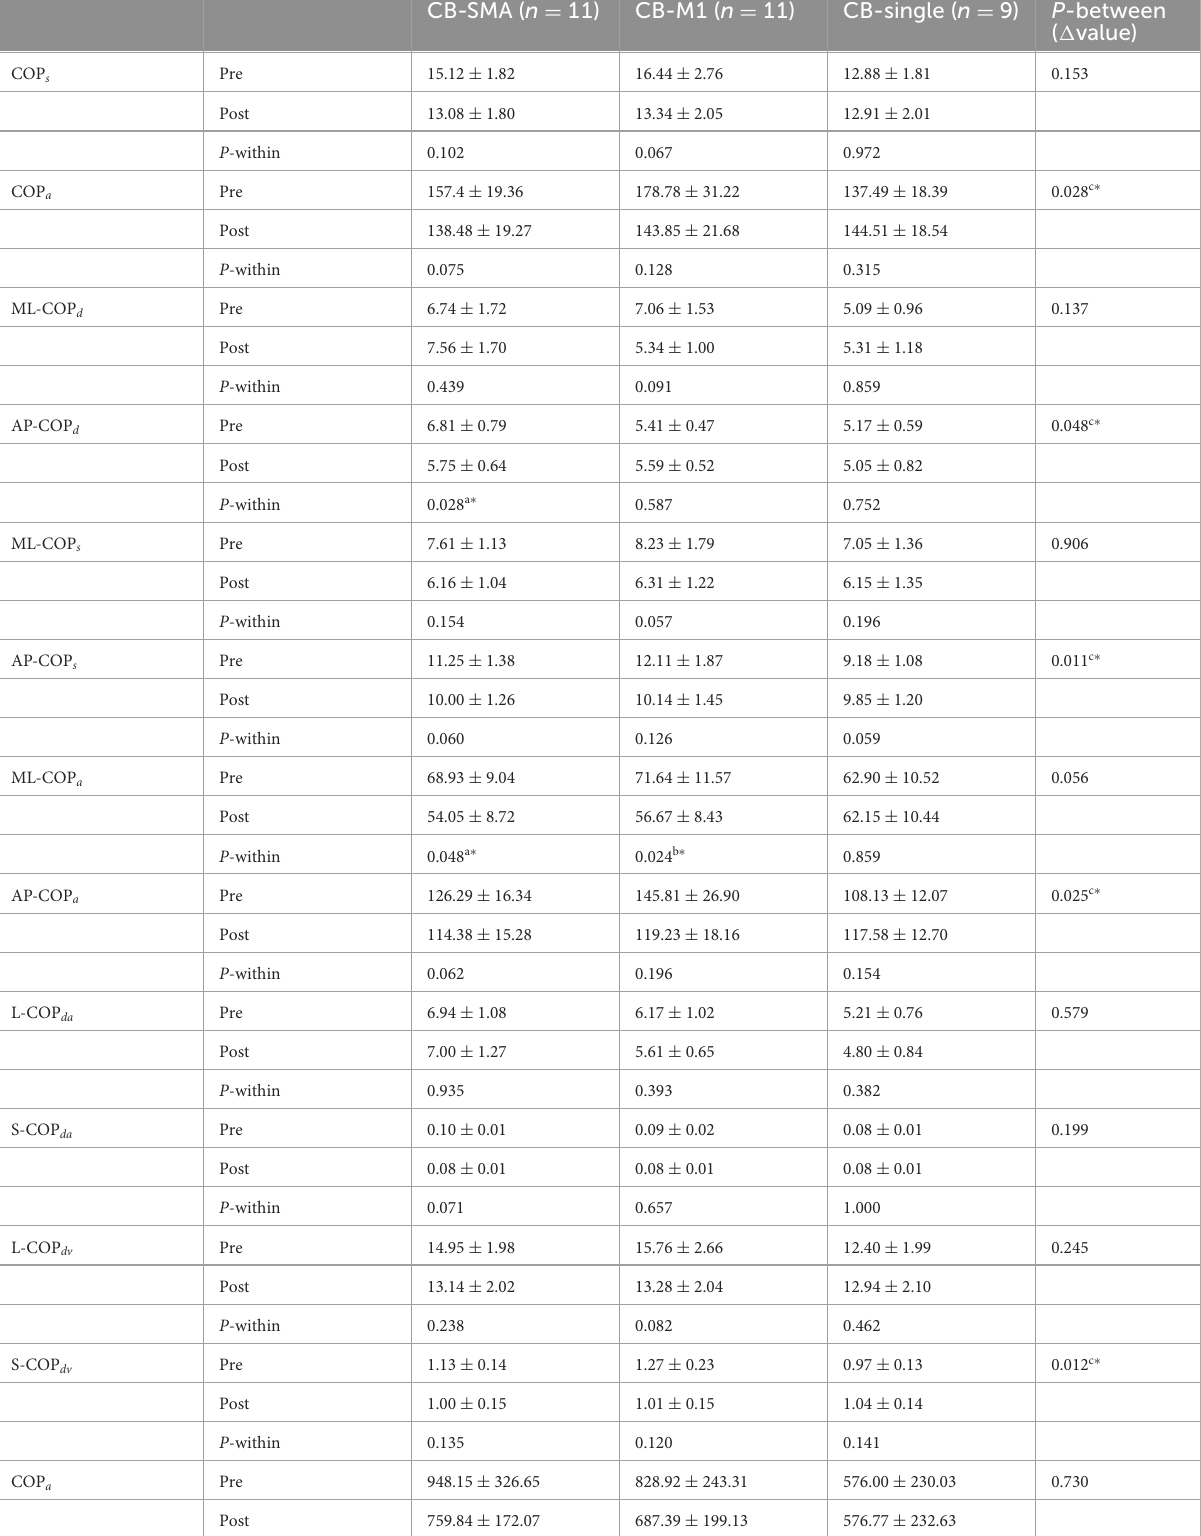
TABLE 3 Balance board parameters in eyes open